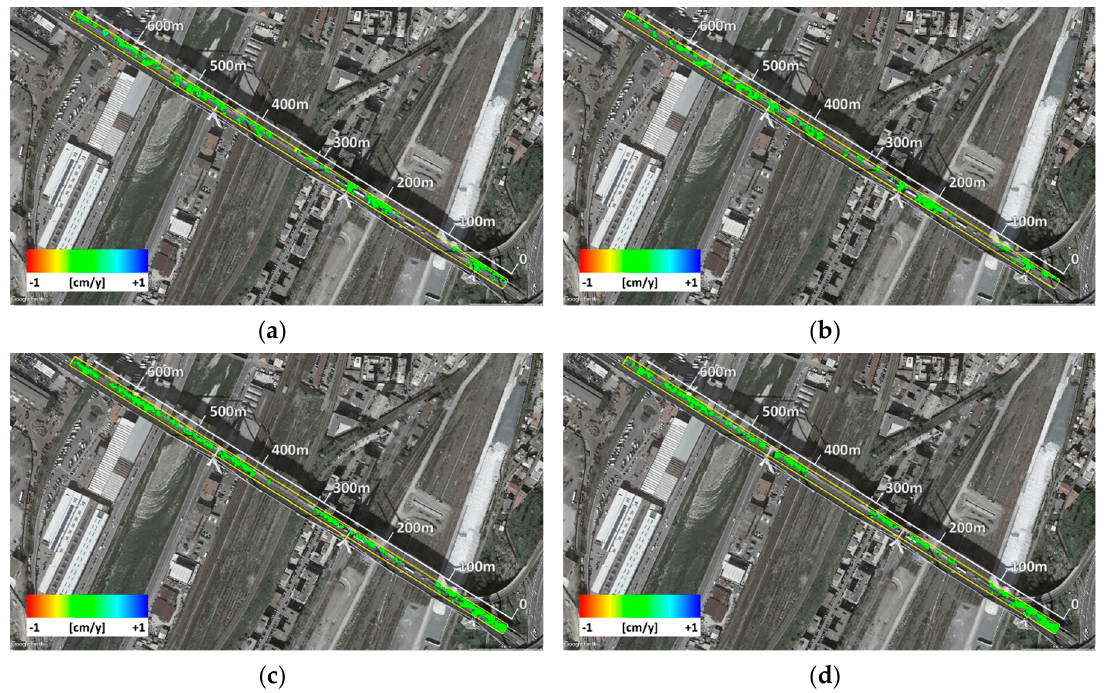
Figure 4. Highlight on the coherent pixels located within the yellow frame, corresponding to the northern roadway, for ( a ) SBAS and ( b ) TomoSAR processing results achieved for the ascending dataset, and ( c ) SBAS and ( d ) TomoSAR results relevant to the descending dataset. Colormap is set according to the estimated velocity with the convention that negative values correspond to departure from the sensor along the Line of Sight (LOS). The white graduated axis represents the longitudinal coordinate of the yellow rectangle whose origin is set at the southern/eastern end of the bridge.